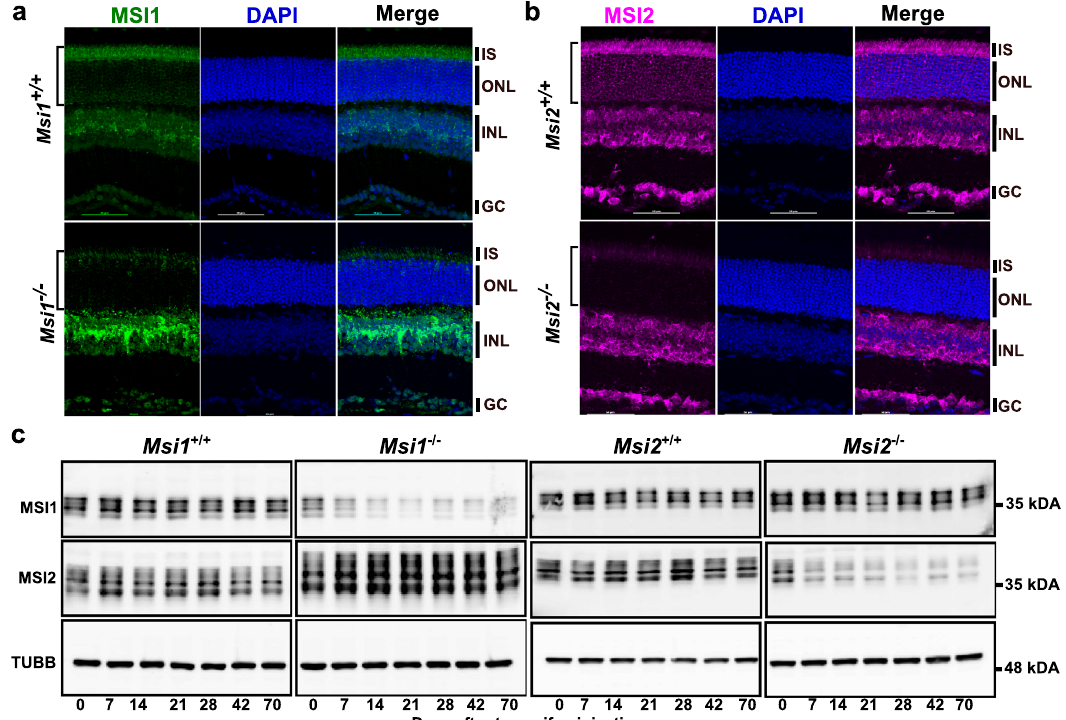
Fig. 3 Induced single knockouts of Msi1 or Msi2 in photoreceptor cells. Immuno fl uorescence micrographs of retinal cross-sections collected 14 days after tamoxifen injection at postnatal day 30 from Msi1 − / − mice and Msi1 + / + littermates ( a ) or Msi2 − / − mice and Msi2 + / + littermates ( b ). Sections were stained with antibodies to MSI1 (green), MSI2 (magenta) and DAPI (blue). The brackets on the left indicate the layer of photoreceptor cells from which the genes are being deleted. IS inner segment (photoreceptor cell layer), ONL outer nuclear layer (photoreceptor cell layer), INL inner nuclear layer, GC ganglion cell layer. Objective, 40X. c Immunoblot of lysates from Msi1 + / + and Msi1 − / − retinas collected between 0 and 70 days after tamoxifen injections and probed with antibodies to MSI1, MSI2 and TUBB (loading control). Size markers indicate the molecular weight in kDA. See Supplementary Fig. 3 for uncropped